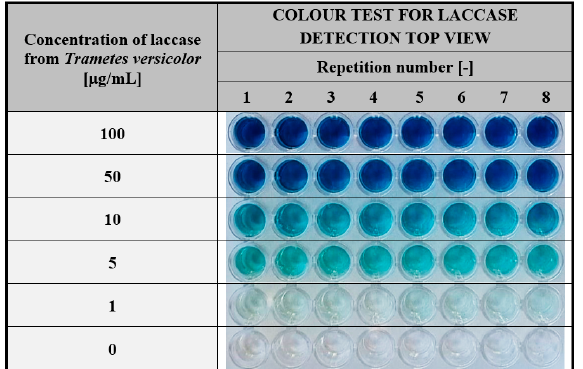
Figure 7. Repeatability of the visual responses of the hydrogel-based test performed for the different concentrations of laccase in phosphate-citrate buffer pH 5.2. Test conditions: hydrogel gelatine matrices containing ABTS at a concentration of 1.5 mg/mL; test time: 60 min.